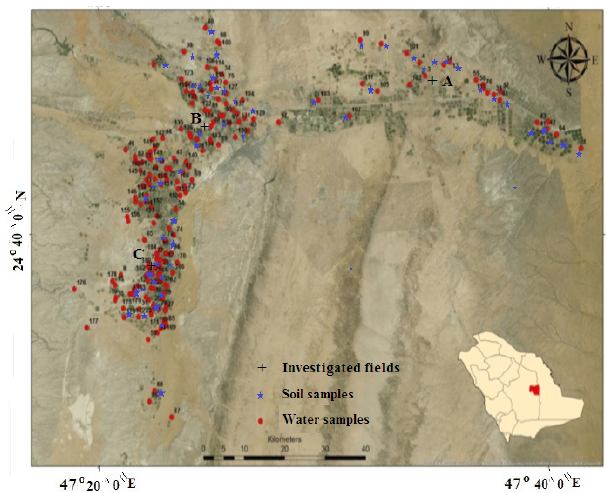
Figure 5. Location of the studied wells, soil samples, and investi- gated